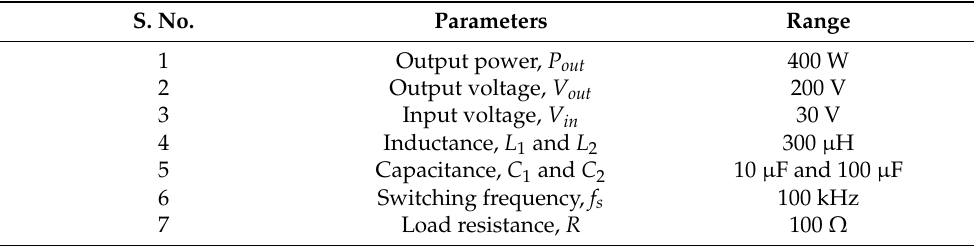
Table 1. Ratings of the MQZS converter.